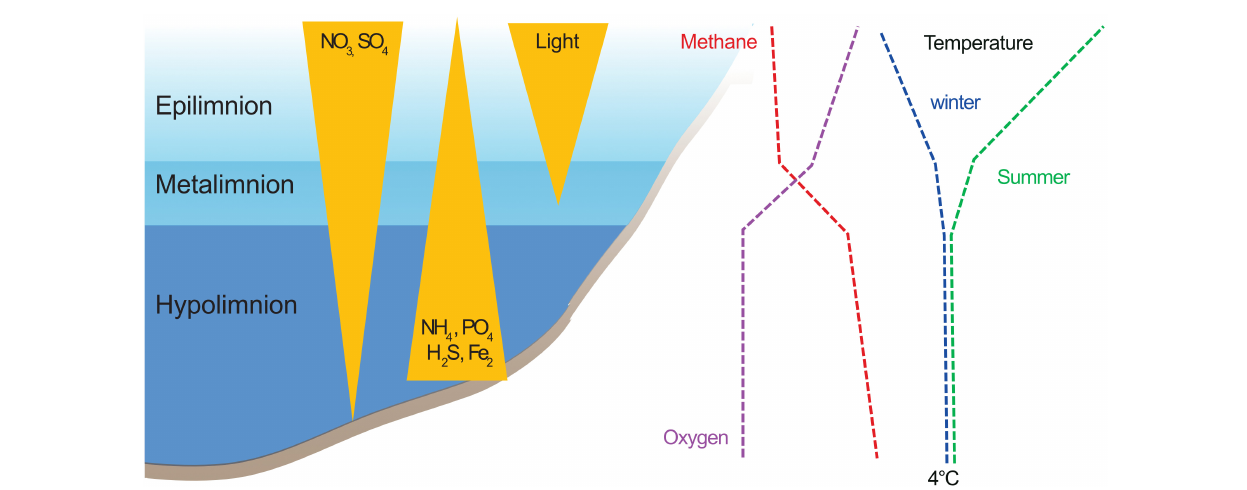
FIGURE 1 | Schematic representation of a stratified lake. During stratification, lake water column is divided into three distinct layers. Whereas the stability and depth of these layers depend on several parameters, such as temperature, salinity, color, morphology of the lake, climate, etc.; the different layers tend to share a few common features. The surface layer, epilimnion , is rich in oxygen while at the lake bottom, in the hypolimnion, anaerobic conditions prevail. Between these two layers, a thin but distinct layer develops, where temperature and oxygen change drastically, this is the metalimnion . The condition in the hypolimnion are favorable for reduced compounds, such as CH 4 , NH 4 , or H 2 S, whereas in the epilimnion, conditions favor oxidation. Concentration curves of reduced and oxidized compounds often cross each other in the metalimnion (e.g., oxygen and methane). During winter, when the lake freezes, the surface water gets colder (i.e., below 4 ◦ C) and the temperatures of the layers are inverted, with the warmer layer being the hypolimnion. The depths of each of the layers are not the same during winter and summer